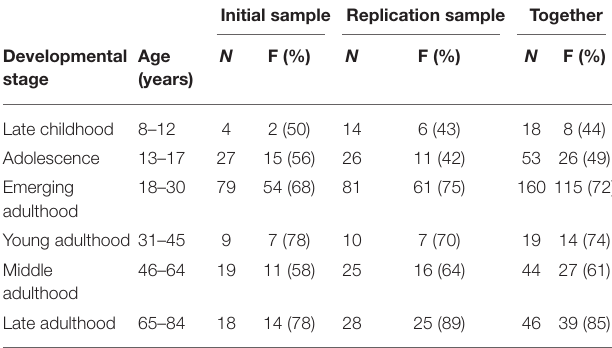
Initial sample Replication sample